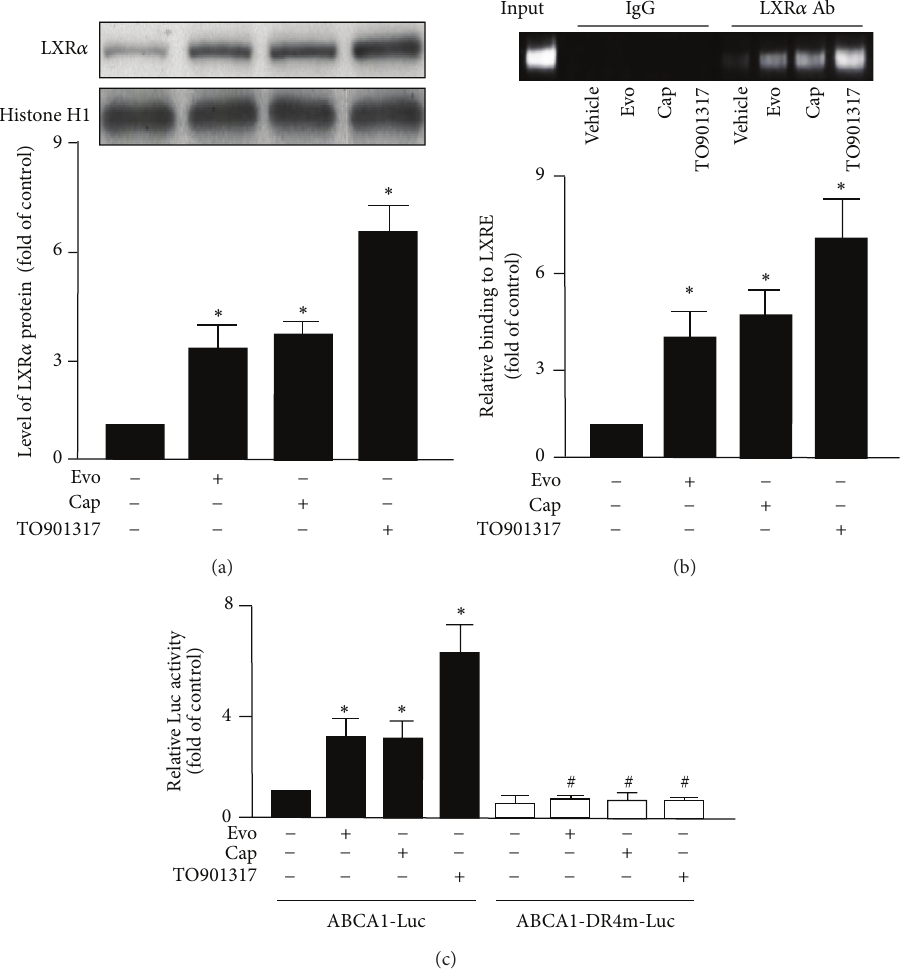
Figure 6: Treatment with TRPV1 agonists increases the activation of LXR 𝛼 in macrophages. (a) BMDMs were pretreated with capsazepine (10 𝜇 M) for 1h then incubated with evodiamine (500nM), capsaicin (10 𝜇 M), or T0901317 (10 𝜇 M) for 6h. Western blot analysis of nuclear protein level of LXR 𝛼 and Histone H1 as a normalization control. (b) Macrophages were treated with vehicle, evodiamine (500nM), capsaicin (10 𝜇 M), or T0901317 for 6h, then immunoprecipitated with anti-LXR 𝛼 or rabbit IgG. PCR amplification involved specific primers for the ABCA1 gene promoter. The amplified DNA products were separated by electrophoresis with 2% agarose gel. (c) Macrophages were transfected with plasmid phABCA1-Luc or phABCA1-DR4m-Luc for 24h, treated with vehicle, evodiamine (500nM), capsaicin (10 𝜇 M), or TO901317 (10 𝜇 M) for 24 h, then lysed for Luc activity assays with renilla activity as an internal control. Data are mean ± SD from 5 independent experiments. ∗ 𝑃 < 0.05 versus vehicle-treated cells, # 𝑃 < 0.05 versus phABCA1-Luc-transfected cells with evodiamine or capsaicin